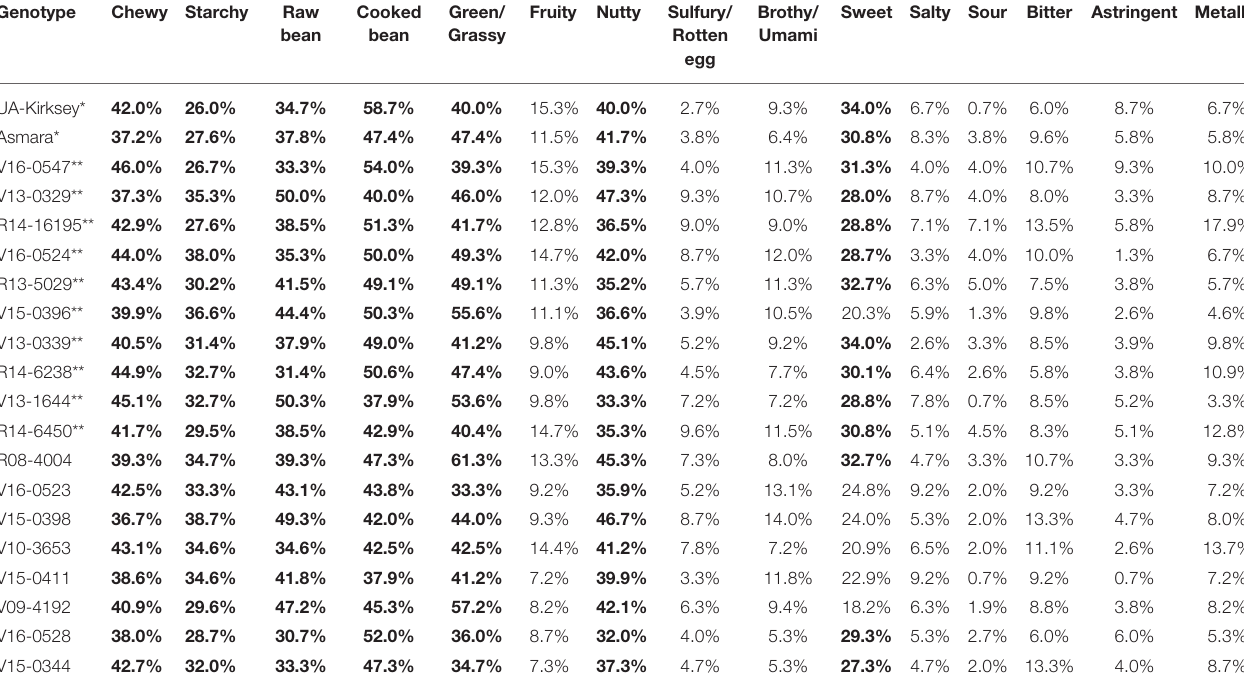
TABLE 4 | Citation frequency (%) for sensory descriptors from Check-All-That-Apply (CATA) list used to describe edamame genotypes in the screening study. Genotype Chewy